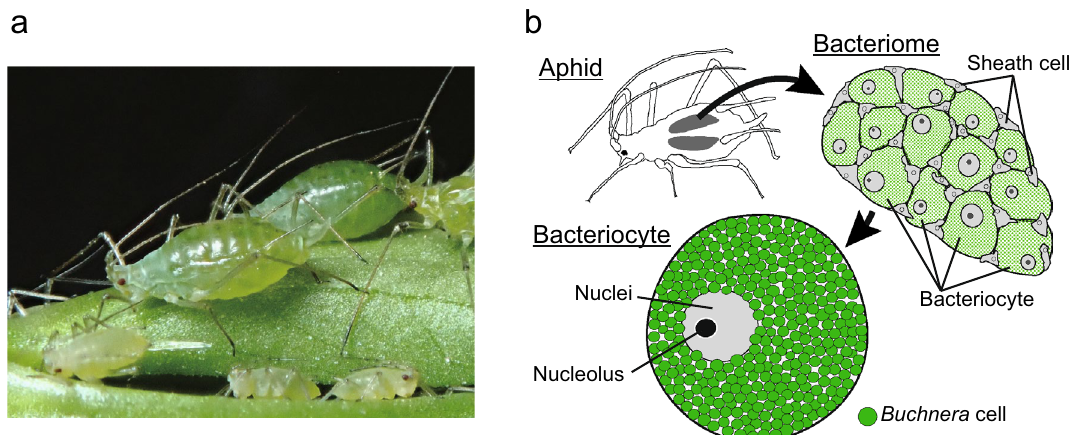
Figure 1. Intracellular symbiosis in the pea-aphid, Acyrthosiphon pisum . ( a ) a photograph of pea-aphids (viviparous females). ( b ) Aphids harbor their bacterial symbionts in the specialized organ, bacteriome. The organ contains two types of cells, bacteriocytes and sheath cells. Bacteriocytes are symbiotic host cells that harbor Buchnera aphidicola in the cytoplasm and are remarkably large (approximately 100 μm in